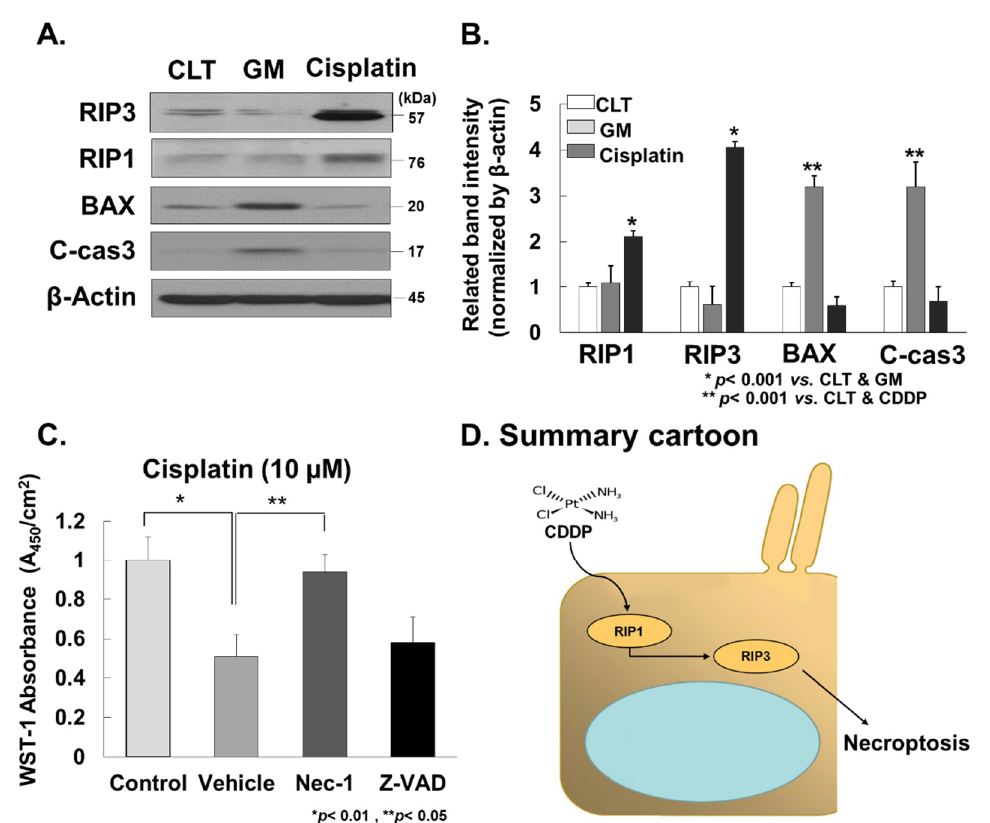
Figure 4. Cisplatin promotes RIP3-dependent necroptosis in cochlea. ( A ) Western blot. RIP1 and RIP3 protein expression levels were significantly elevated in cochlear tissues treated with cisplatin compared to the vehicle control. However, in GM-treated rats BAX and cleaved caspase-3 protein expression were significantly elevated in cochlear tissues compared to the vehicle control. ( B ) Densitometry analysis. ( C ) Inhibitor experiment in the HEI-OC1 cell line. HEI-OC1 cells were pre-treated with Nec-1(10 µM) or Z-VAD (100 nM) for 1 h before cisplatin (10 µM) was added. Nec-1 showed a markedly protective effect for the HEI-OC1 cell line treated with cisplatin (10 µM), but Z-VAD did not show this. ( D ) Summary cartoon. CTL, control; GM, gentamicin. C-cas-3, cleaved caspase-3; CDDP, cisplatin; Nec-1, necrostain-1.